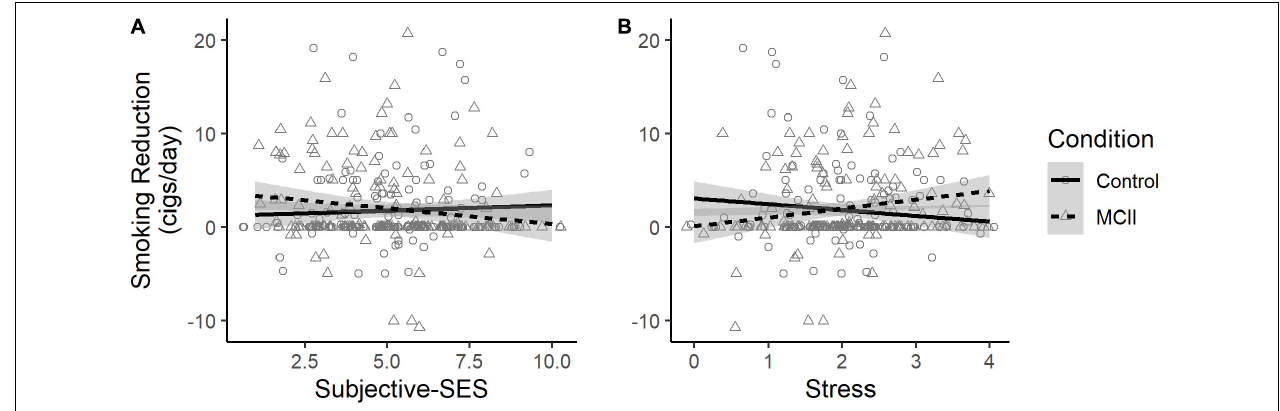
FIGURE 2 | Effect of condition on smoking reduction, depending on (A) subjective-SES and (B) stress. Jitter was added to better visualize data density. MCII, mental contrasting with implementation intentions; cigs, cigarettes.